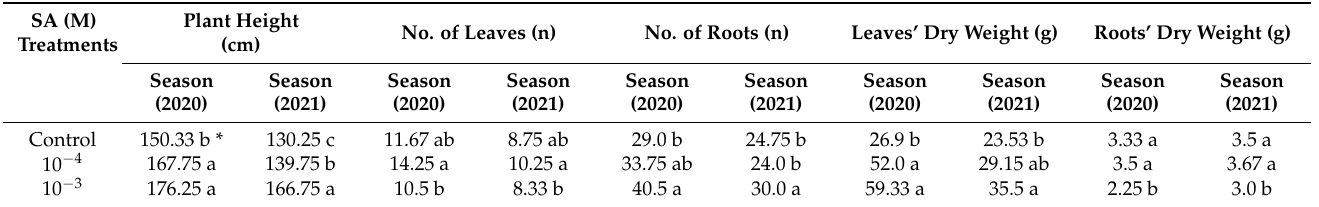
Table 4. Effects of salicylic acid (SA) treatment on the plant height (cm), the number of leaves and roots (n), and the dry weight (g) of leaves and roots of C. longa .